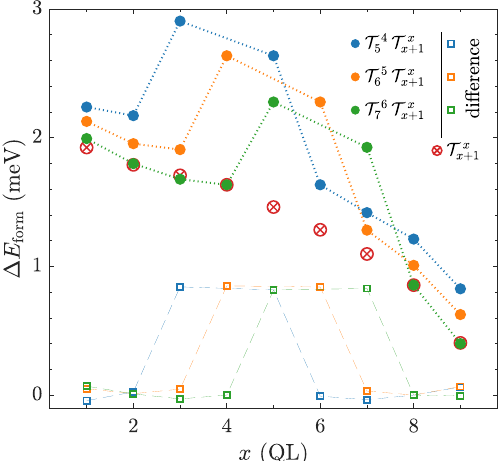
Figure 3. ( (cid:108) ) Relative formation energy of two TPs as a function of their position within the structure, which consists of 10 Bi 2 Se 3 QLs. ( ⊗ ) Relative formation energy of a single TP is depicted for comparison. Relative formation energies belonging to the different numbers of TPs are related to distinct absolute energies. ( (cid:3) ) Energy curves associated to two TPs with subtracted single TP curve contribution.